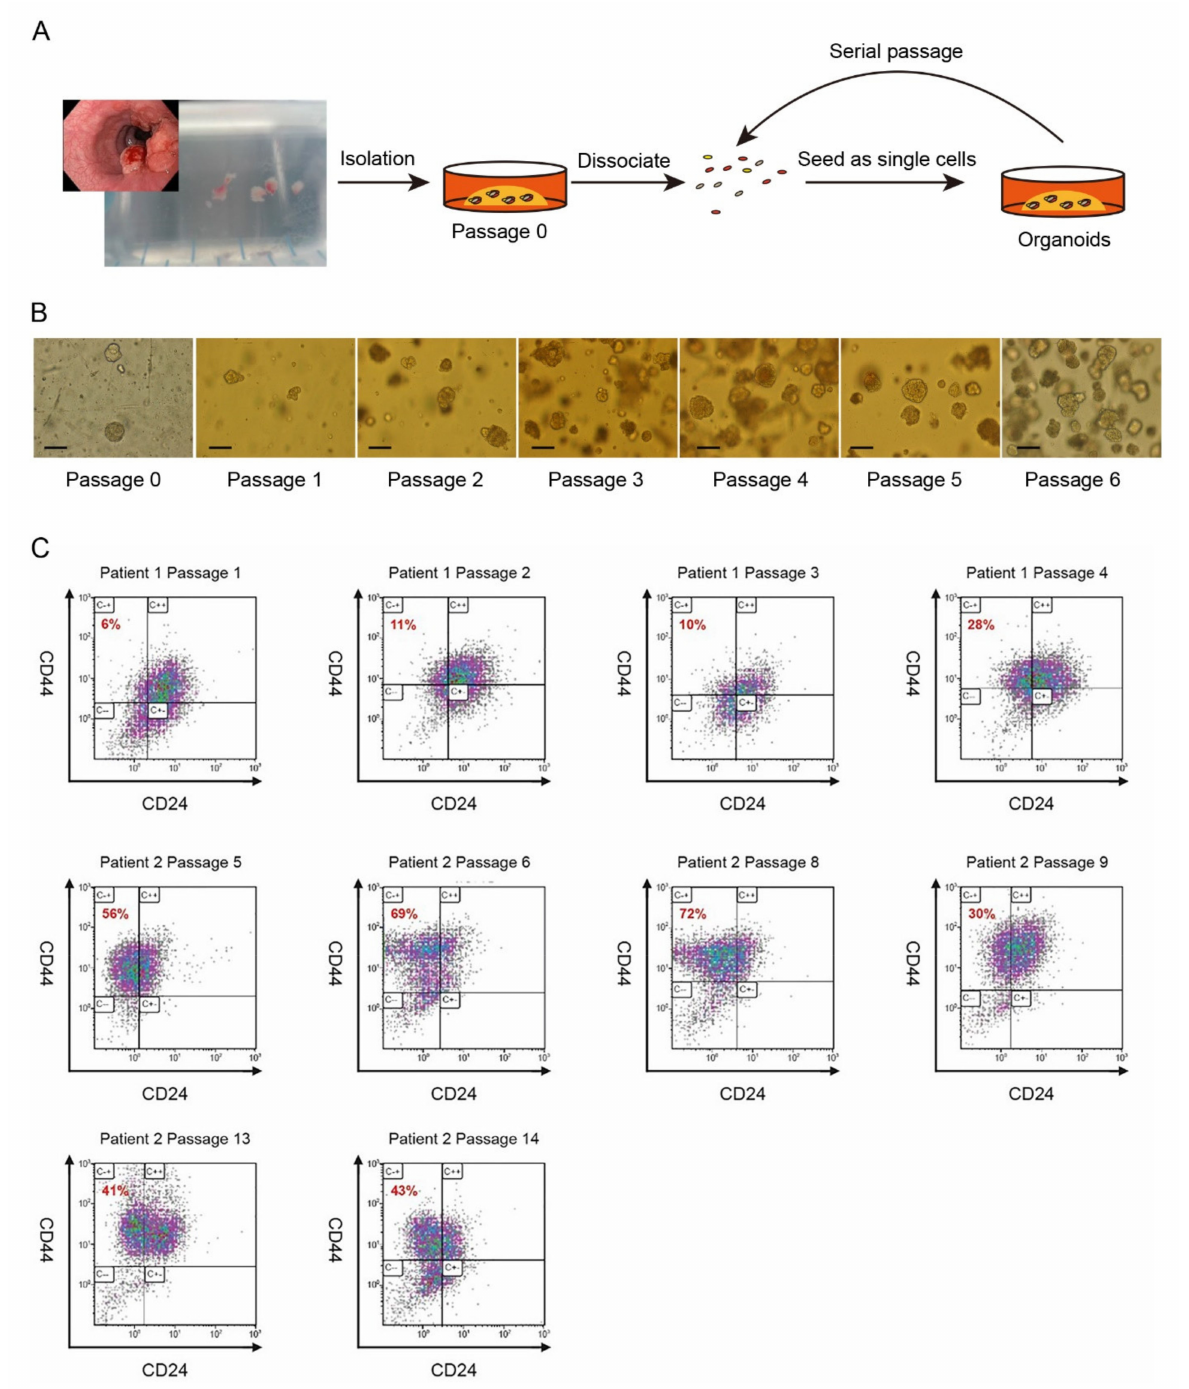
Figure 5. CD44 + /CD24 − is present in EC patient-derived Organoids (ec-PDOs). ( A ) Scheme showing an overview of the isolation and expansion of ec-PDOs. ( B ) Representative images of ec-PDOs in different passages. Scale bar = 100 µ m. ( C ) Representative FACS plots of CD44 + /CD24 − expression in different ec-PDOs in different